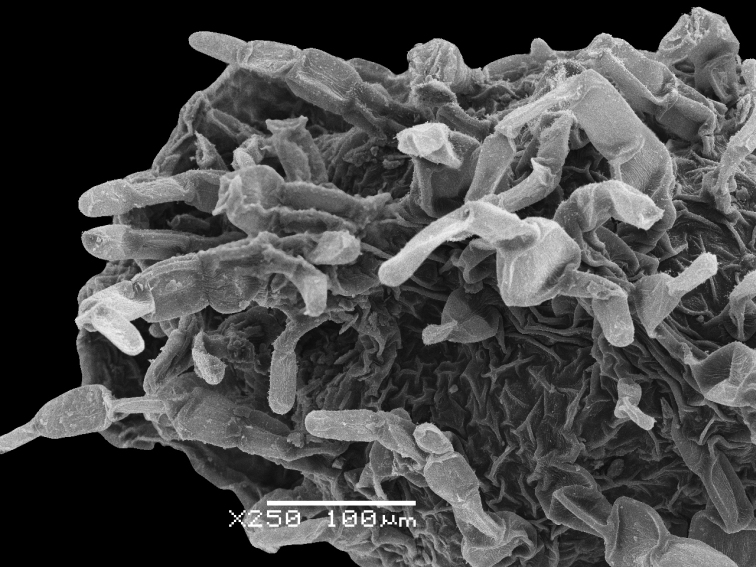
SEM micrograph of Dysphaniatibetica perianth segment, magnification 250×.